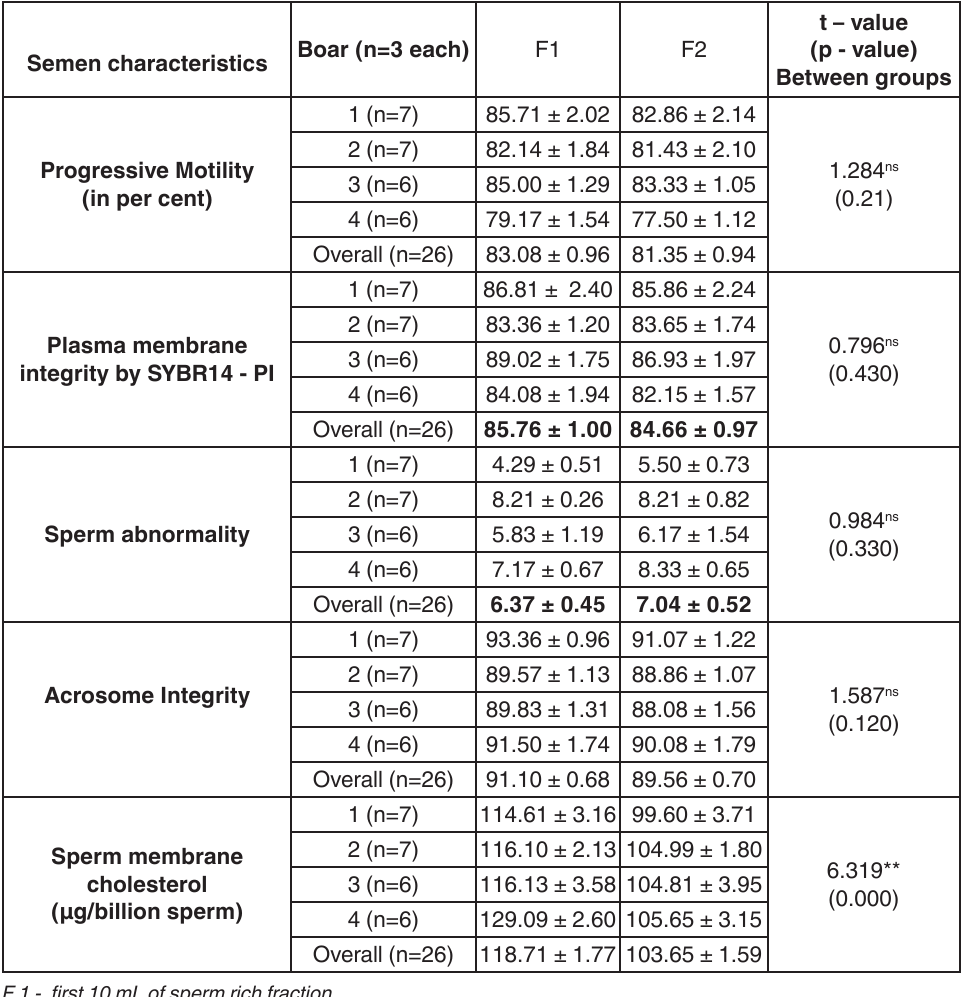
Table 3. Sperm progressive motility, Sperm plasma membrane integrity (using SYBR-PI), abnormality and acrosome integrity and sperm cholesterol content (Mean ± SE)in different fractions of Large white Yorkshire boar fresh semen ejaculate, expressed in per